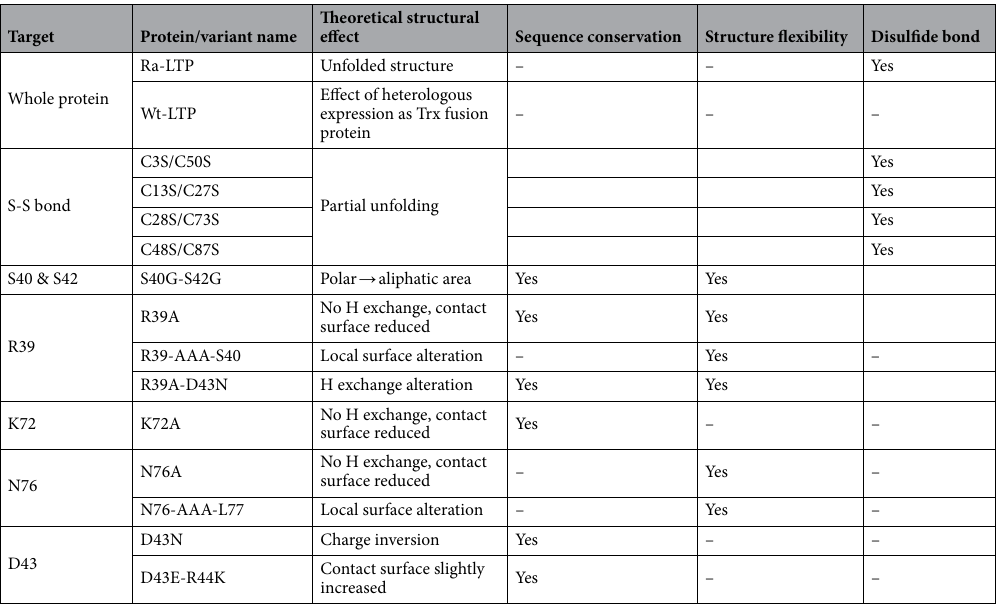
Table 1. Summary of mutations and their theoretical effect on structure. LTP: lipid transfer protein. Ra-LTP: reduced/alkylated LTP1. S-S: disulfide. Trx: thioredoxin. Wt-LTP: recombinant wild-type wheat